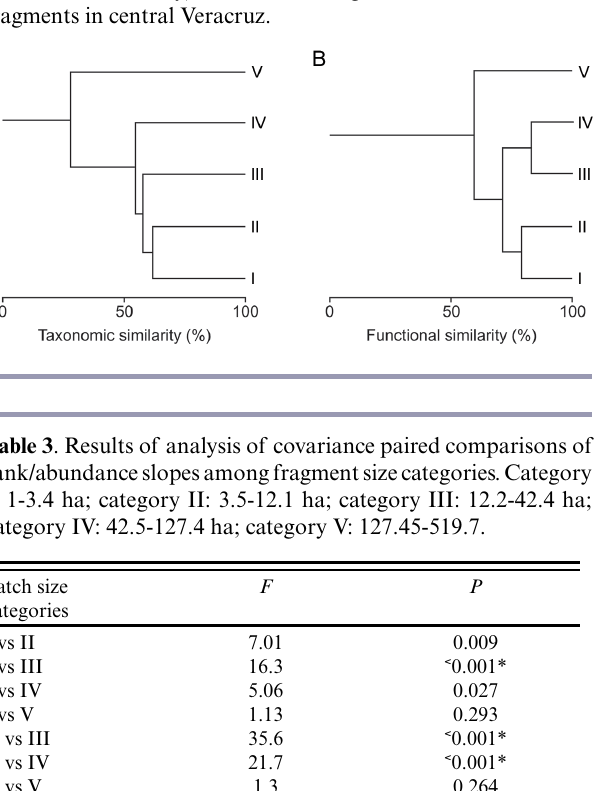
Fig. 2 . Bray-Curtis group average link cluster analysis for (A) overall avian community composition (taxonomic similarity) and (B) main dietary resource groups of the bird community (functional similarity) for five size categories of cloud forest fragments in central Veracruz.